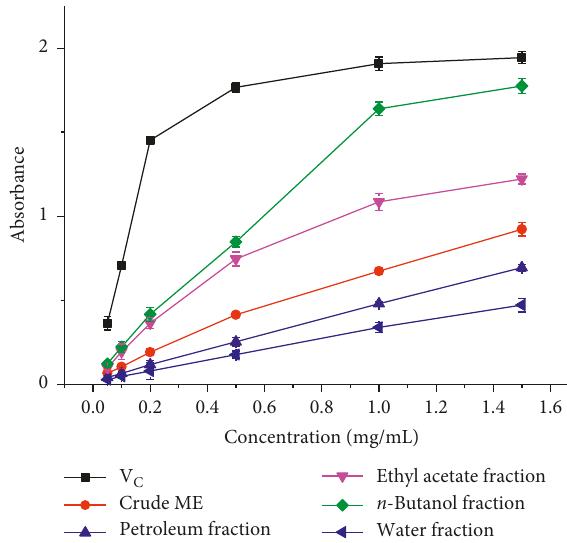
Figure 11: Reducing power of crude ME, V traction fractions extracted from ME.